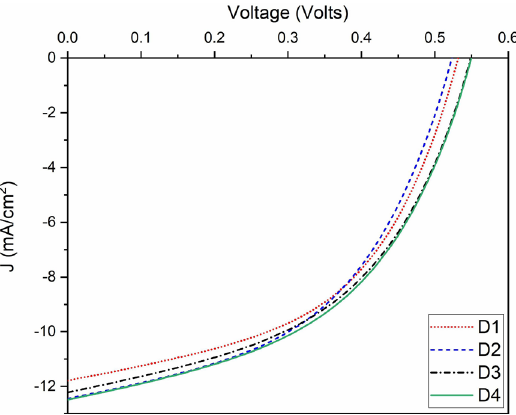
Figure 12. J-V curves of the device fabricated in the Experiment D with the configuration of FTO/TiO